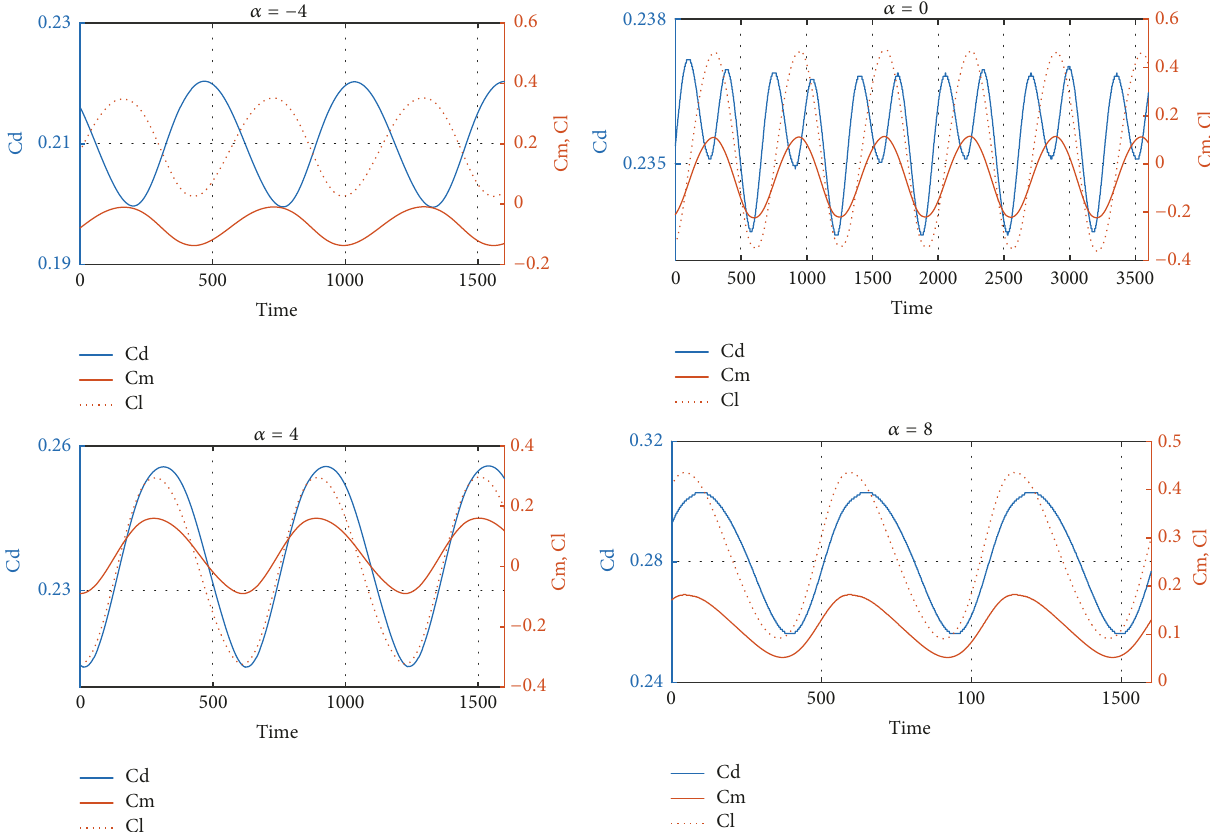
Figure 8: Time histories of load coefficients at different angles of attack (a part of the simulation time is shown, and the simulation time is normalized by the time step value, i.e., 3.5 × 10 −5 ).